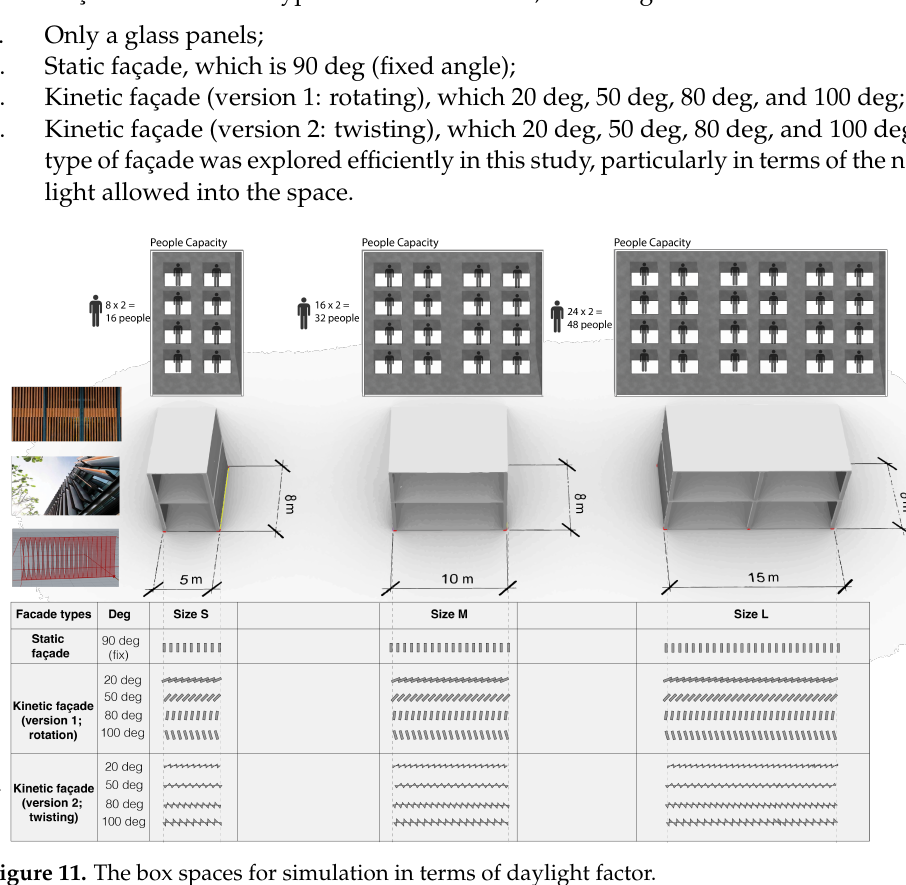
Figure 11. The box spaces for simulation in terms of daylight